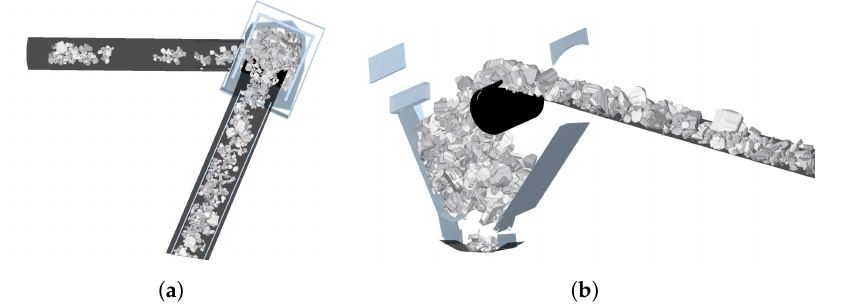
Figure 9. Observed failure: ( a ) simulation of material flow through the transfer station at a capacity of 900 Mg/h and ( b ) the observed arch